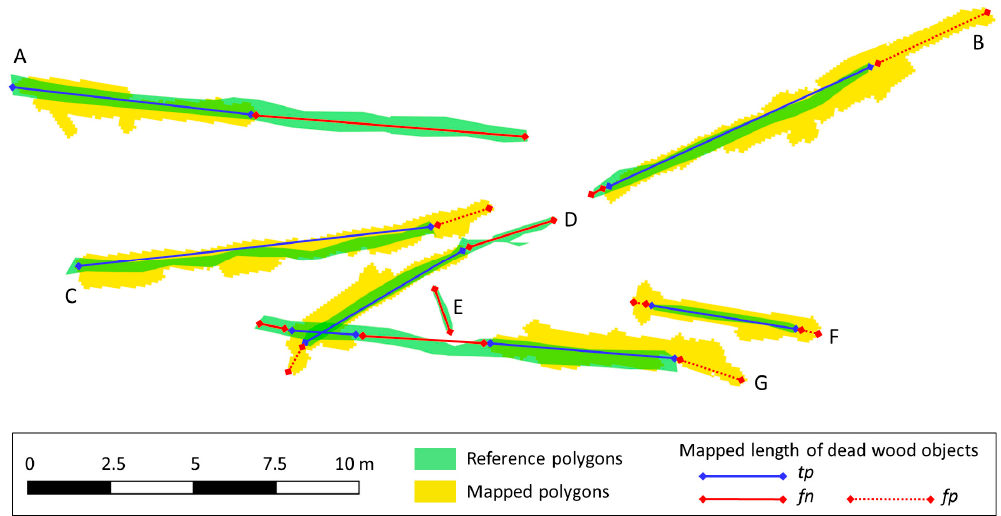
Figure 7. Mapped and manually digitized CWD for a small subset of the Huss site to illustrate the length-based accuracy analysis approach. Seven dead wood objects are shown (A–G). The length of the overlap area of reference polygons and mapped polygons corresponding to the same CWD object (solid blue lines) was defined as correctly detected ( tp length ). Missed out parts of CWD objects (solid red lines) correspond to fn length , while dotted red lines refer to overestimation ( fp length ). The length measurements were summed up for the entire validation area (one fourth of the Huss site).